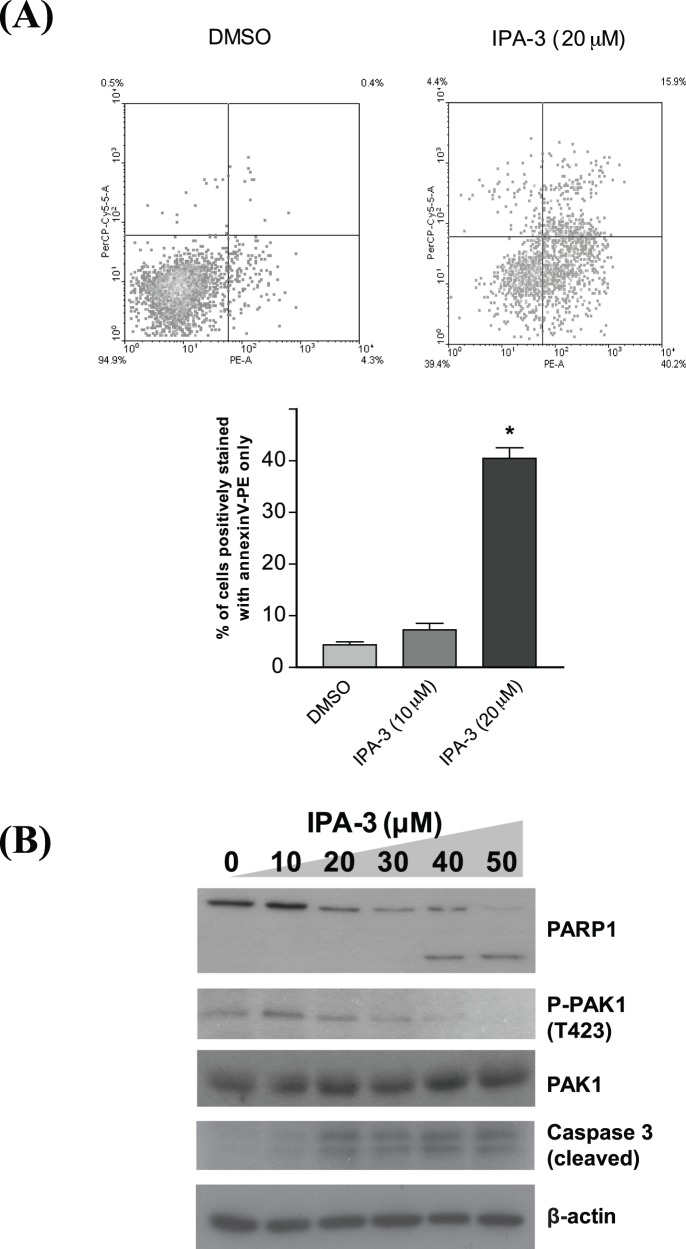
The induction of apoptosis by IPA-3.(A) Annexin V-7ADD staining assay. The fluorescence signals of annexin V-PE and 7-AAD were detected with PE-A and Per-Cy5-5-A channels, respectively (upper panel). The percentage of H2M cells stained with annexin V-PE only under different treatments was shown in a bar chart (lower panel). *P<0.001 (ANOVA) compared with the DMSO control. (B) Serum-starved H2M cells were treated with increasing dosages of IPA-3 together with serum replenishment for 24 hours. Western blotting analysis of PARP1, P-PAK1 (T423), total PAK1 and cleaved caspase 3 was performed.